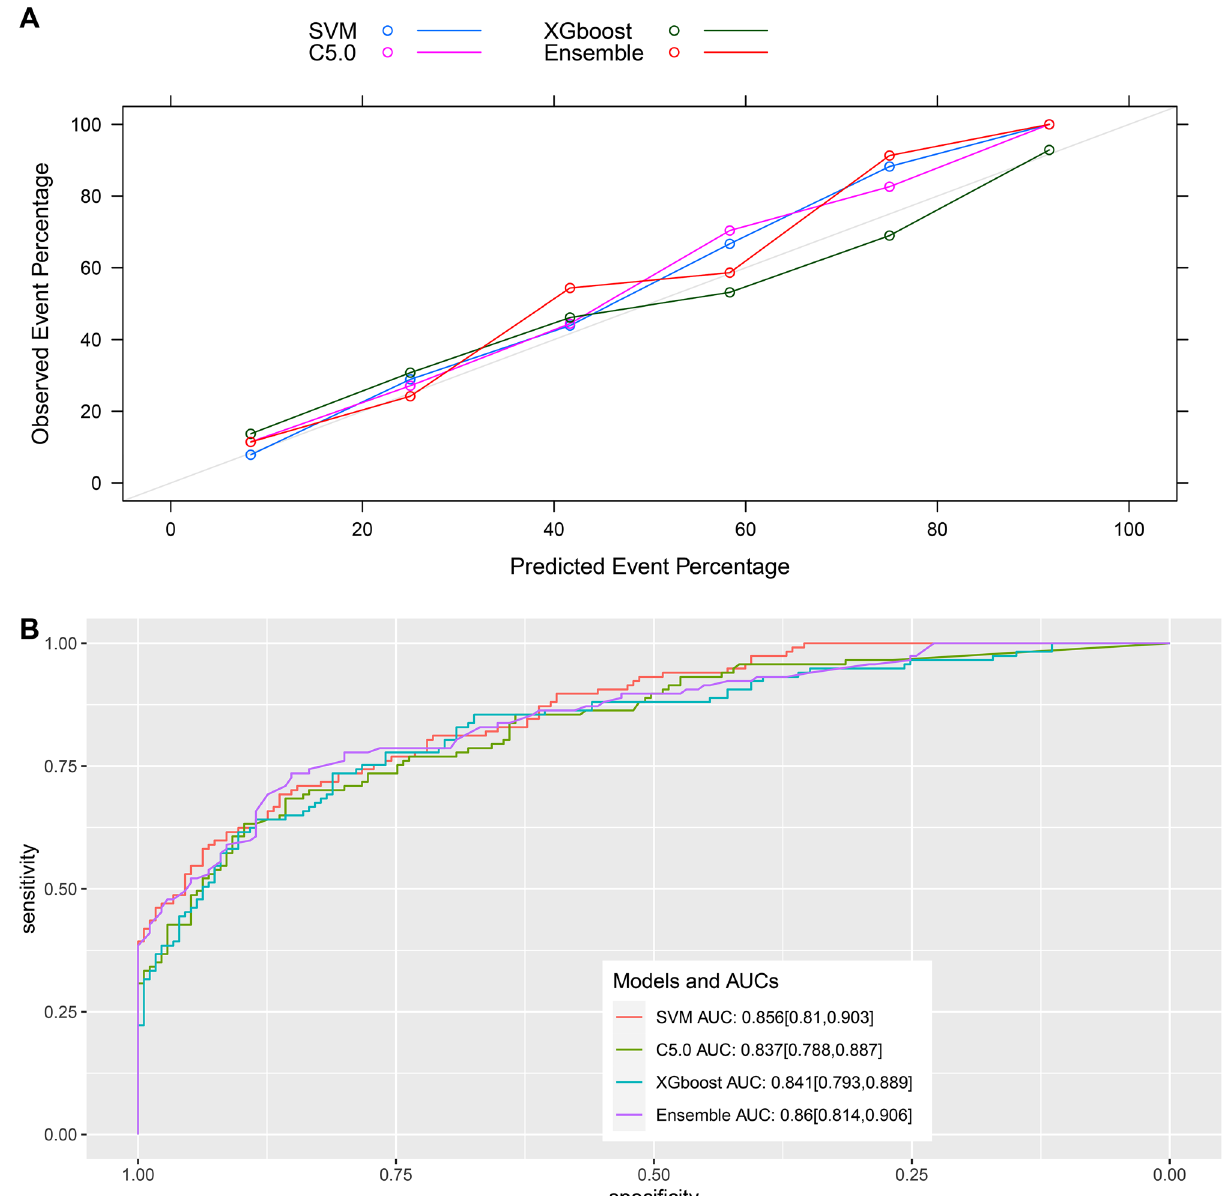
Figure 3. Evaluation of model performance in the internal validation dataset. ( A ) The calibration plot shows the consistency between observed and predicted risks for persistent acute kidney injury. ( B ) Discrimination of the machine-learning models in the internal validation dataset. SVM, support vector machine; XGBoost, extreme gradient boosting; AUC, area under the curve. The number in parentheses indicates the 95% confidence